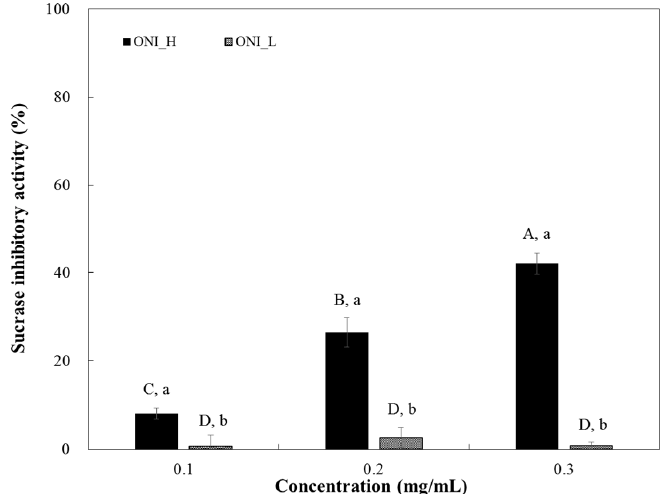
Figure 3. Dose dependent changes in rat small intestinal sucrase inhibitory activities (% inhibition) of two different onion extracts (ONI_H and ONI_L). The results were expressed as mean ± S.D. with three independent experiments in triplicate. Different corresponding letters indicate significant differences at p < 0.05 by Duncan’s test. A–D The first letters in uppercase indicate significant differences among all samples and a–b the second letters in lowercase are different between ONI_H and ONI_L within same concentration.